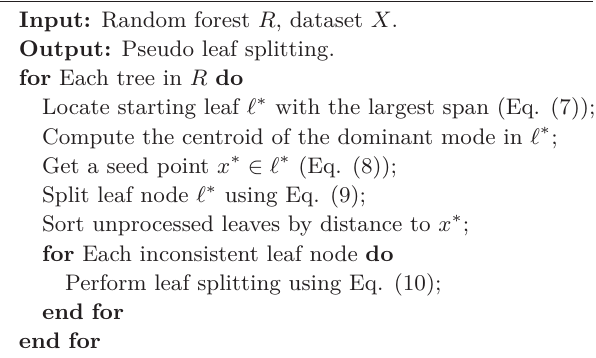
Algorithm 1 Pseudo leaf